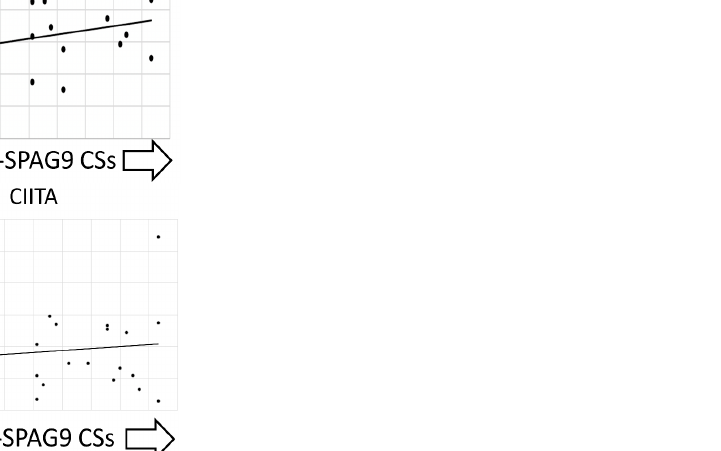
Figure 2. Correlation of SPHK2 and CIITA gene expression with TCR CDR3-SPAG9 electrostatic CSs. (See also Table 1; Table S8).